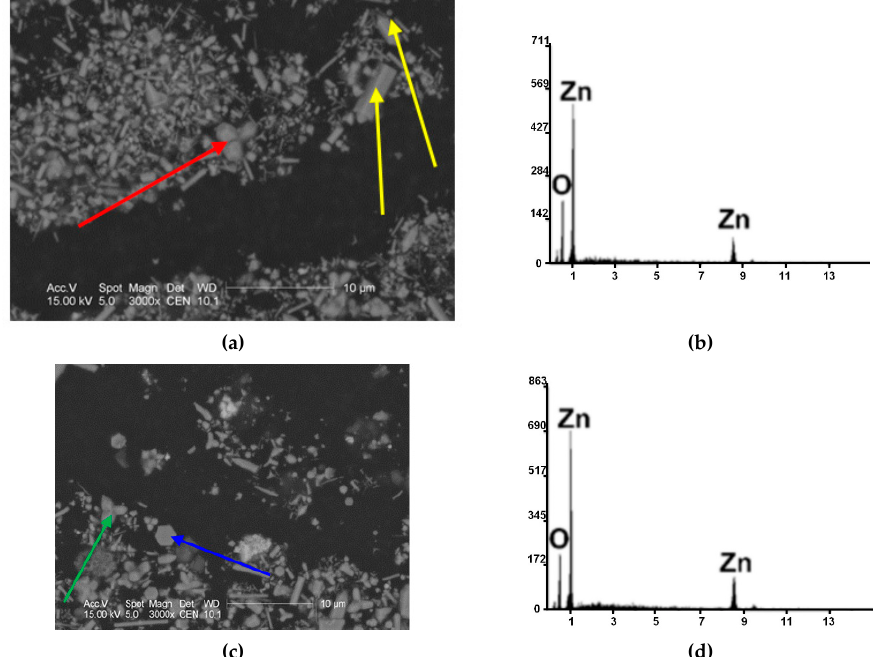
Figure 8. Dust from the Zn rectification process (sample No. 10): ( a , c ) SEM images: red arrow indicates zincite crystals forming twins; yellow arrows—single zincite crystals in the form of a column, sometimes with pyramidal ends; green arrow—twinning of columnar zincite crystals with pyramidal ends; blue arrow—hexagonal crystal of zincite; ( b , d ) the EDS spectrum.